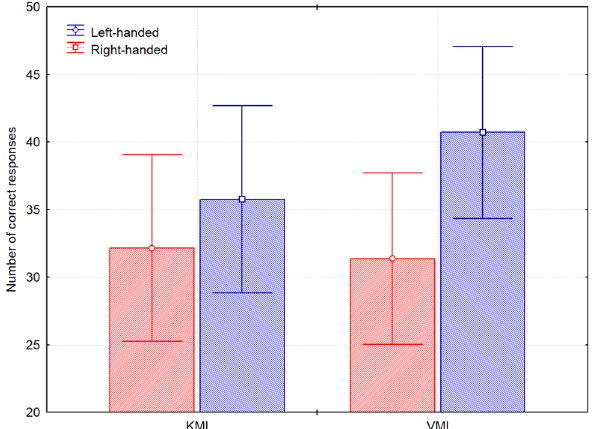
Figure 1. Differences in the number of correct responses related to the effects of Task × Group. The vertical bars represent standard error. Used software to create the images in this figure: STATISTICA version 12 (StatSoft, Inc., Tulsa, OK, USA, https:// www. tibco.